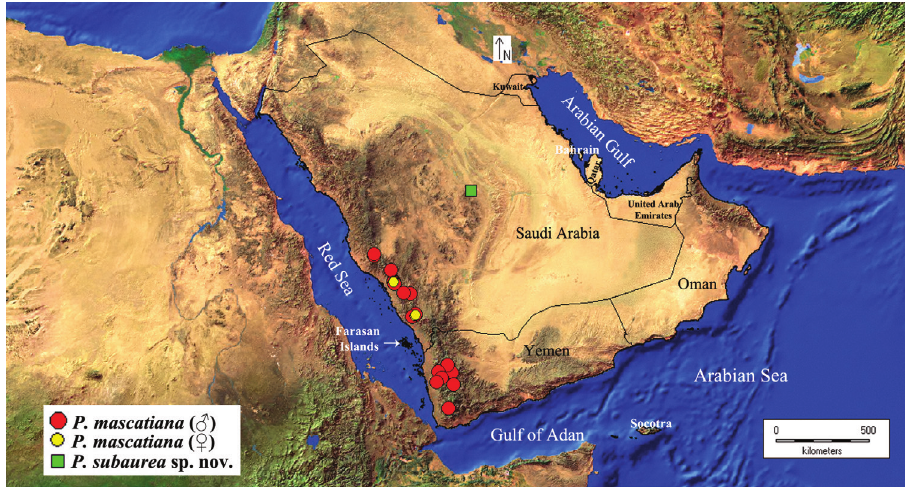
Figure 2. Distribution map of Pseudophotopsis mascatiana Invrea, and P. subaurea sp. nov. in the Ara- bian